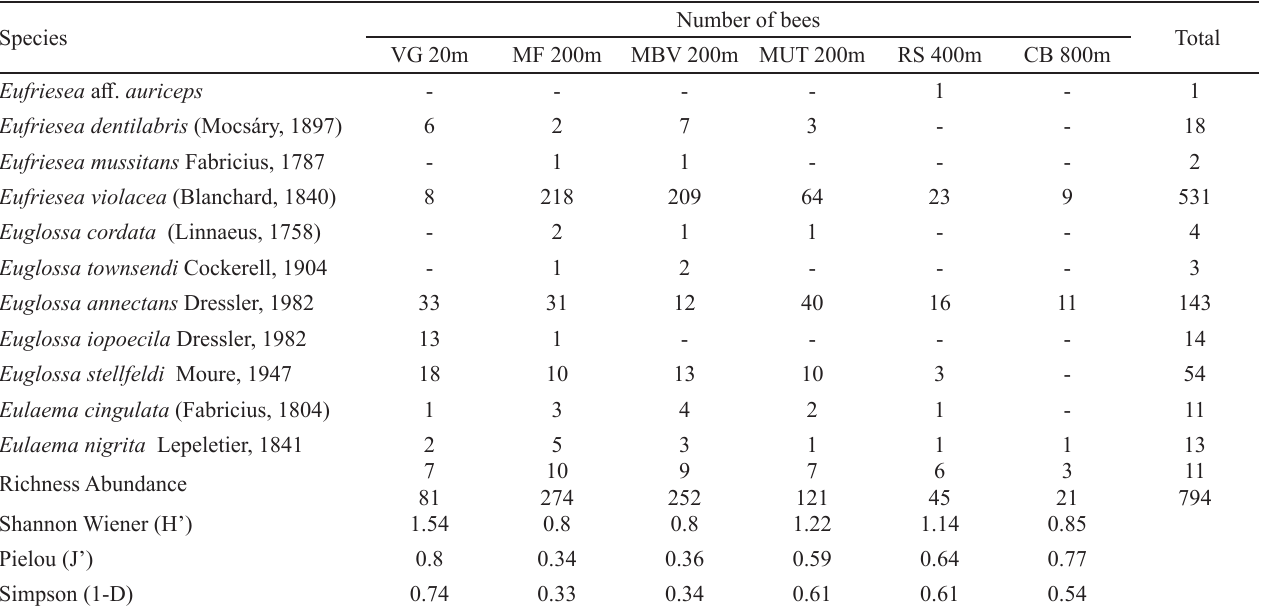
Table 1 . Captured species of Euglossini during the period of September/2013 to April/2014, and September/2014 to April/2015. Locations’